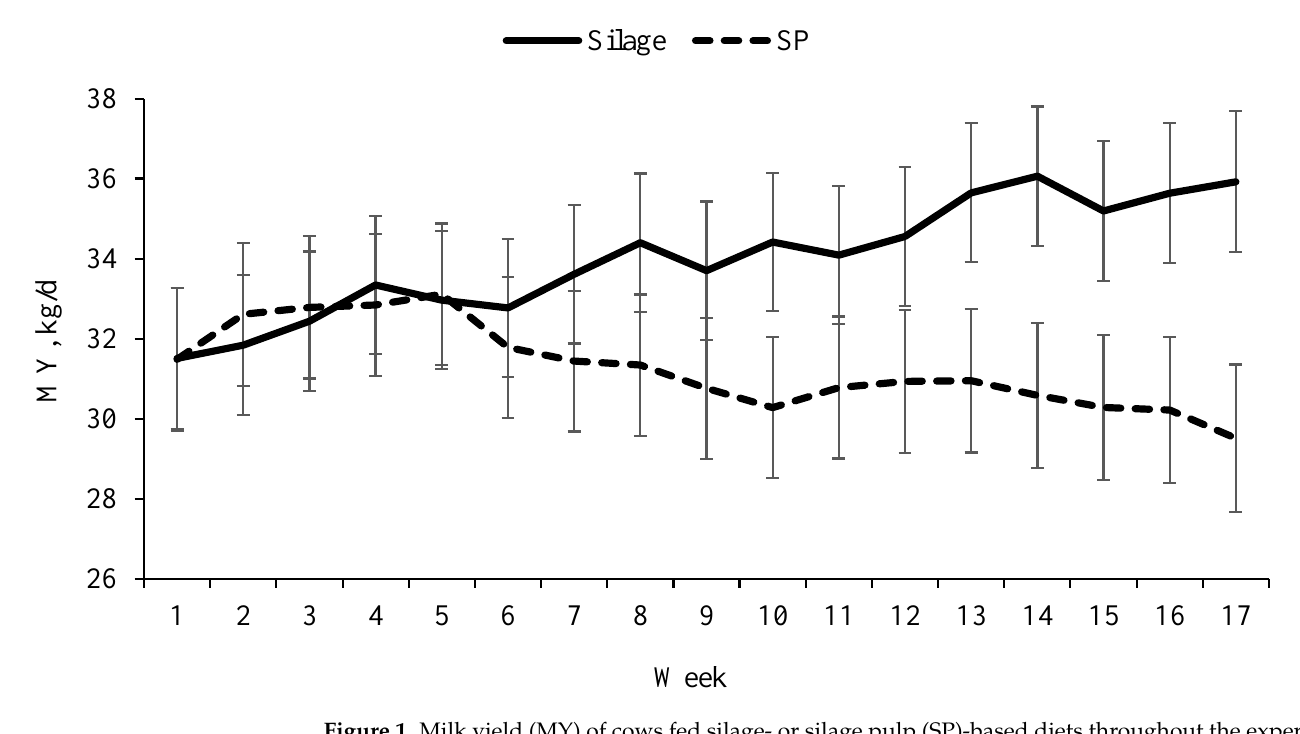
Figure 1. Milk yield (MY) of cows fed silage- or silage pulp (SP)-based diets throughout the experiment. Error bars indicate standard error of the mean. Statistical significance between treatments within each week (week, p -Value) was: 1, p = 0.991; 2, p = 0.723; 3, p = 0.873; 4, p = 0.816; 5, p = 0.943; 6, p = 0.643; 7, p = 0.314; 8, p = 0.159; 9, p = 0.175; 10, p = 0.059; 11, p = 0.130; 12, p = 0.100; 13, p = 0.035; 14, p = 0.015; 15, p = 0.030; 16, p = 0.018; 17, p = 0.006.